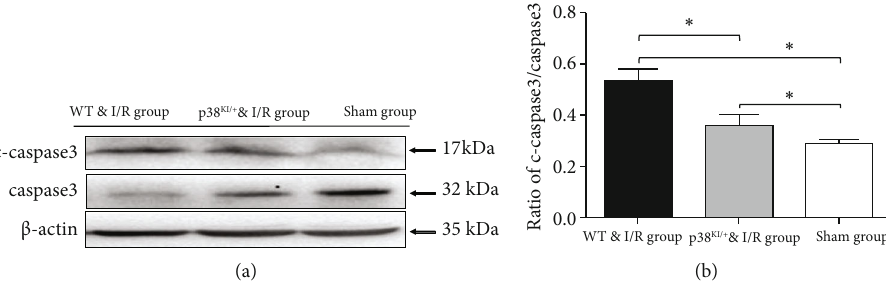
Figure 5: p38 MAPK knockdown reduced the expression of c-caspase-3 in hippocampus CA1 pyramidal cells. (a) Representative images of western blotting in WT and p38 KI/+ mice after ischemia/reperfusion surgery at 9 weeks of age. (b) Quanti fi cation of c-caspase-3 activation expression (cleaved-caspase-3/caspase-3) in the hippocampus, mice in the sham group, the WT & I/R group, and the p38 KI/+ & I/R group. n = 3 per group; ∗ p < 0 : 05 , sham group vs. I/R group; ∗ p < 0 : 05 , p38 KI/+ & I/R group vs. I/R group. ∗ p < 0 : 05 by one-way